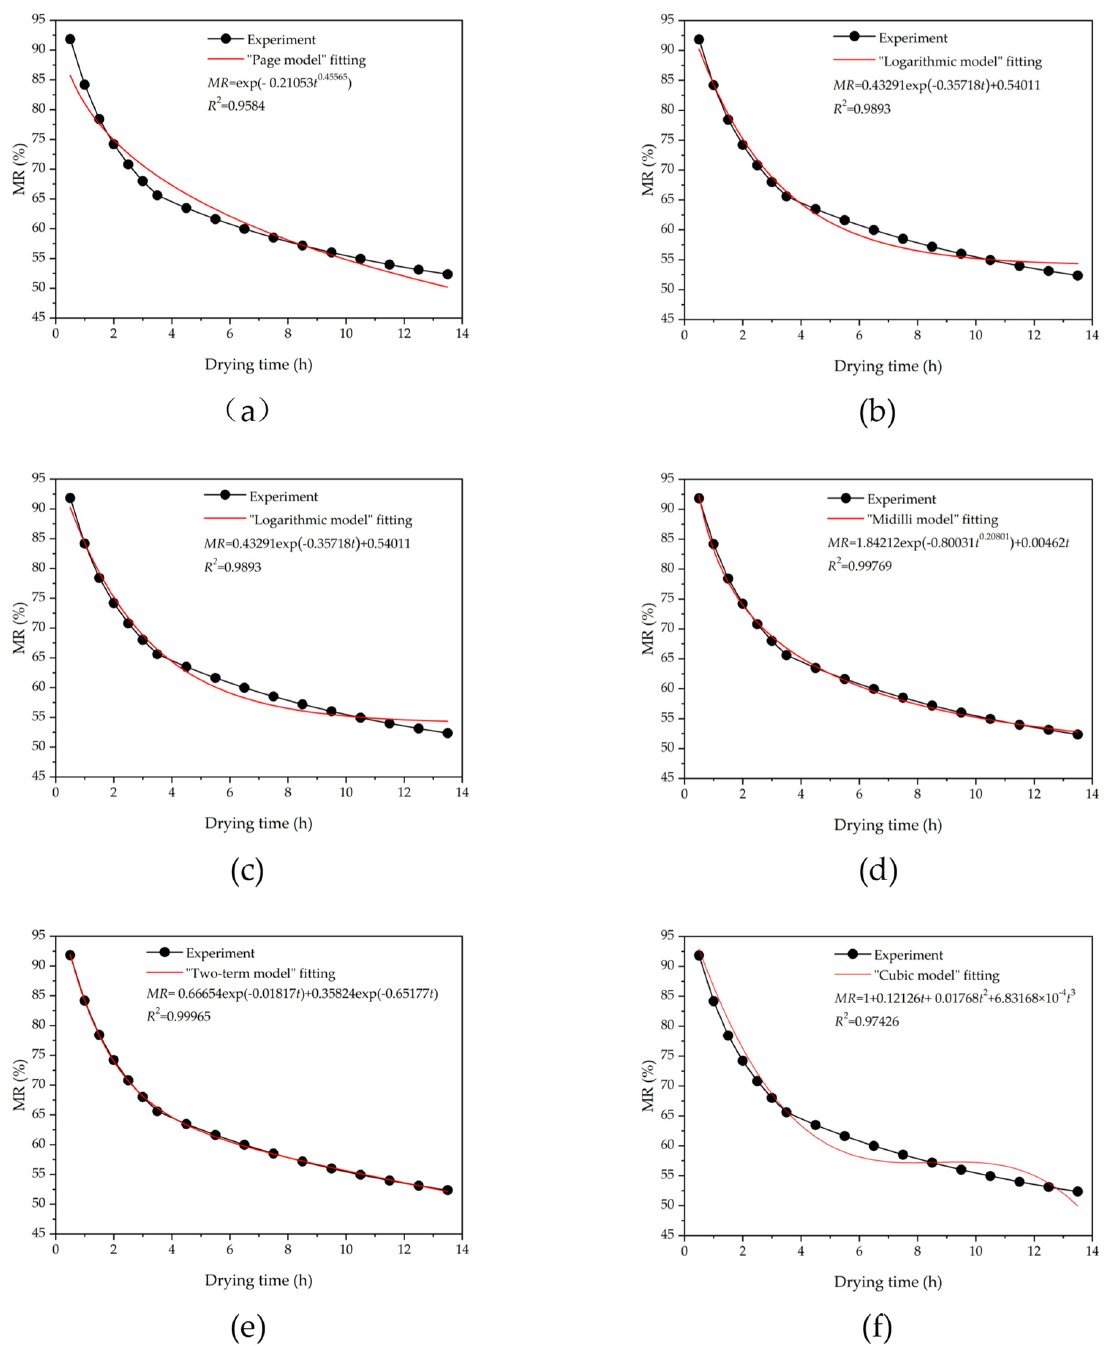
Figure 7. The drying curves fitted by several common models: ( a ) Page model, ( b ) Henderson and Pabic model, ( c ) Logarithmic model, ( d ) Midilli model, ( e ) Two − term model, ( f ) Cubic model.